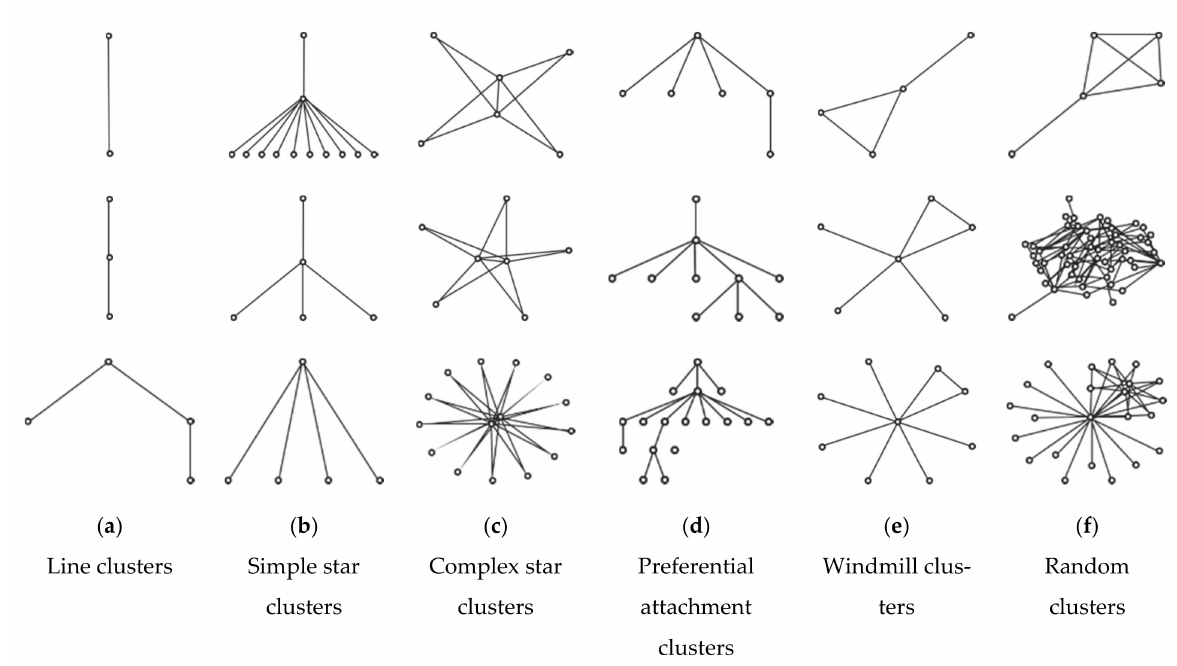
Figure 5. Several versions of a single variable structure topology type with their respective names. Other topological versions conform to the same